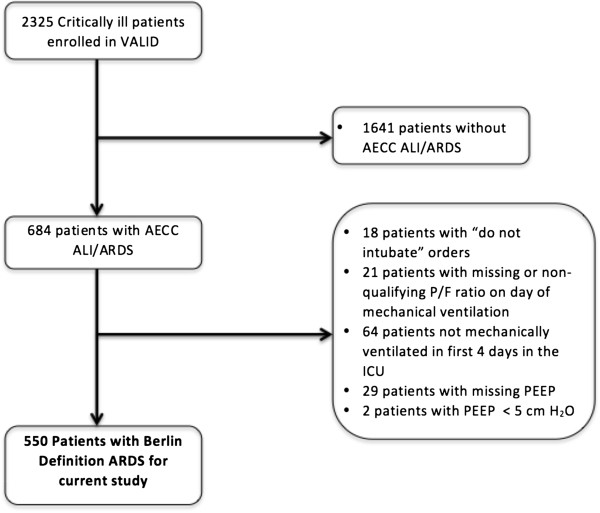
Flow diagram of the patients included in the current study.